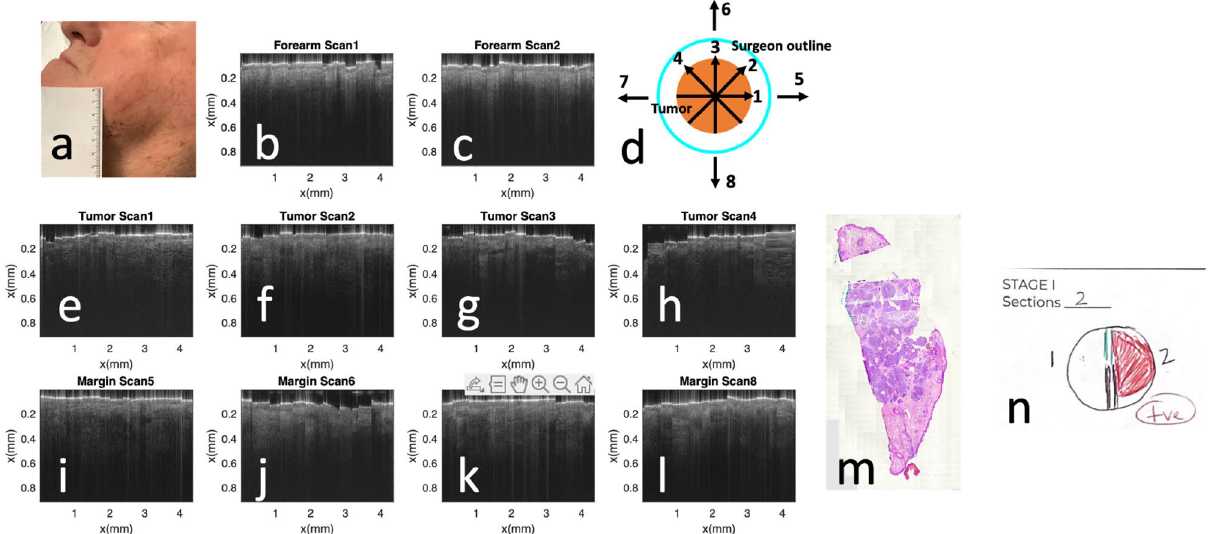
Figure. 7. ( a ) Clinical photo taken from the patient; ( b,c ) OCT image obtained from the forearm of the patient; ( d ) scanning pattern used to profile the tumor; ( e–h ) OCT images obtained following trajectories 1–4 in Fig. 6d; ( i–l ) OCT images obtained following trajectories 5–8 in Fig. 6d; ( m ) result of histology examination; ( n ) Mohs histology documentation, depicting histologically positive Stage 1 margins.